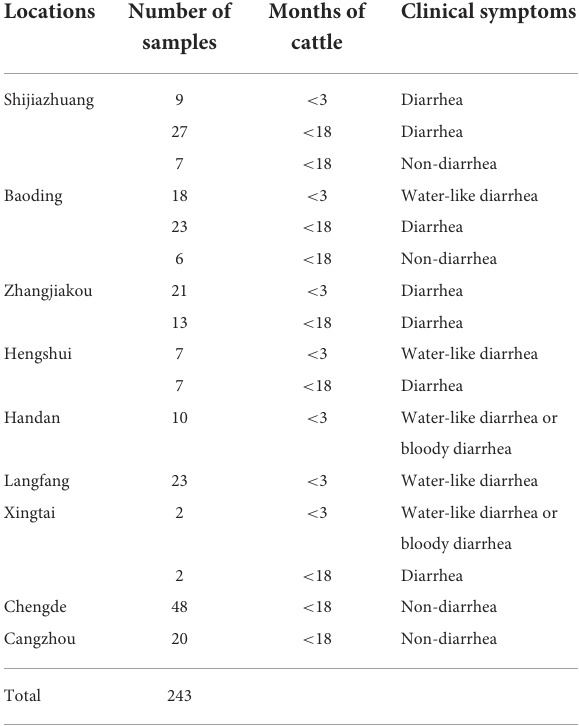
TABLE 1 Detailed information on the collected bovine fecal